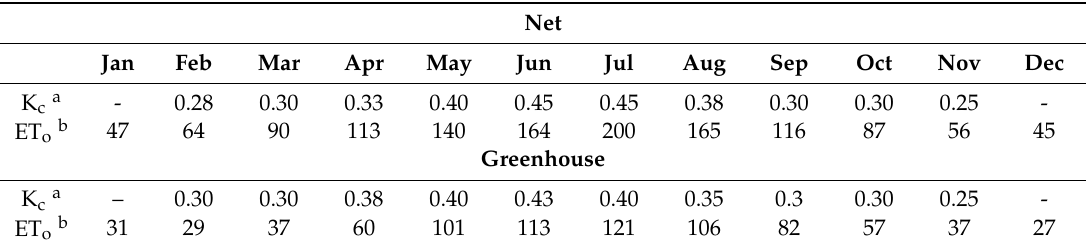
Crop coe ffi cients (Kc) and evapotranspiration (ET o ) (mm) for net and greenhouse cropping systems.